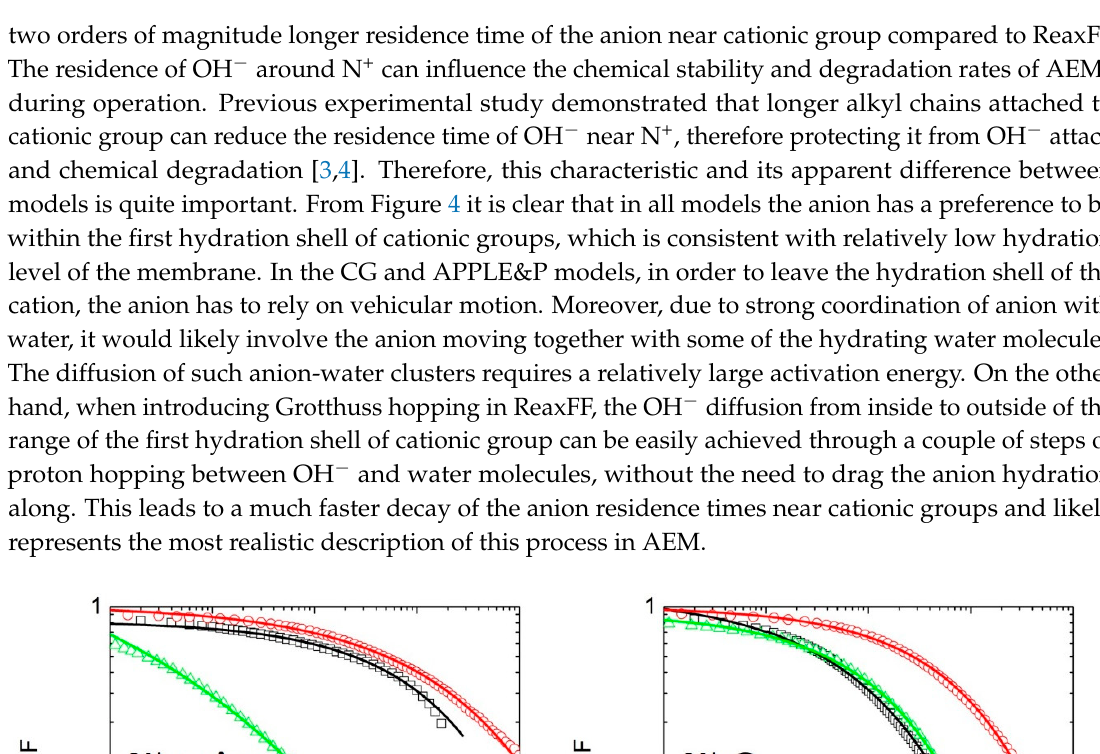
Table 2. Characteristic residence times (in ps) of anion and H 2 O and their ratio.